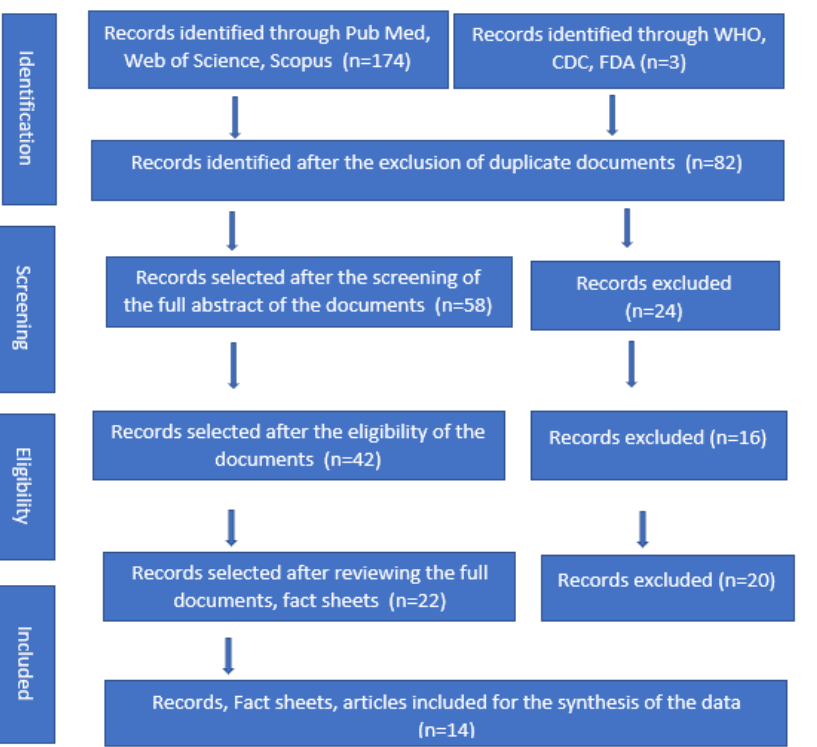
Figure 1. PRISMA flow diagram for the selection of organizations, fact sheets and documents about JYNNEOS and ACAM2000 monkeypox vaccines.